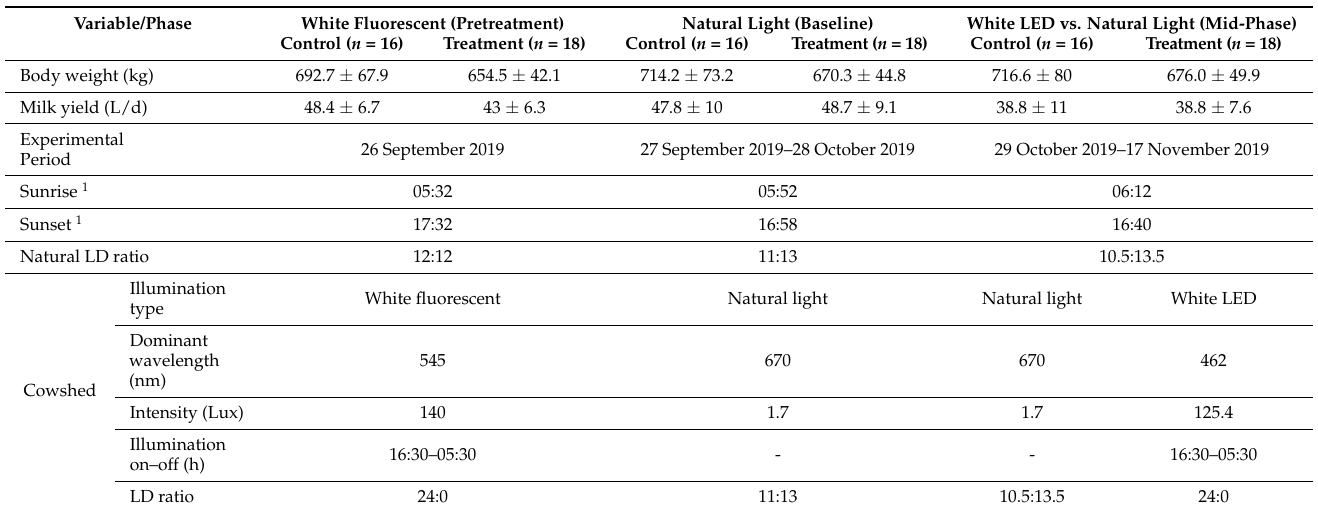
Table 1. Illumination conditions and selected parameters collected at the end of the experimental phases. The data are presented as mean ±